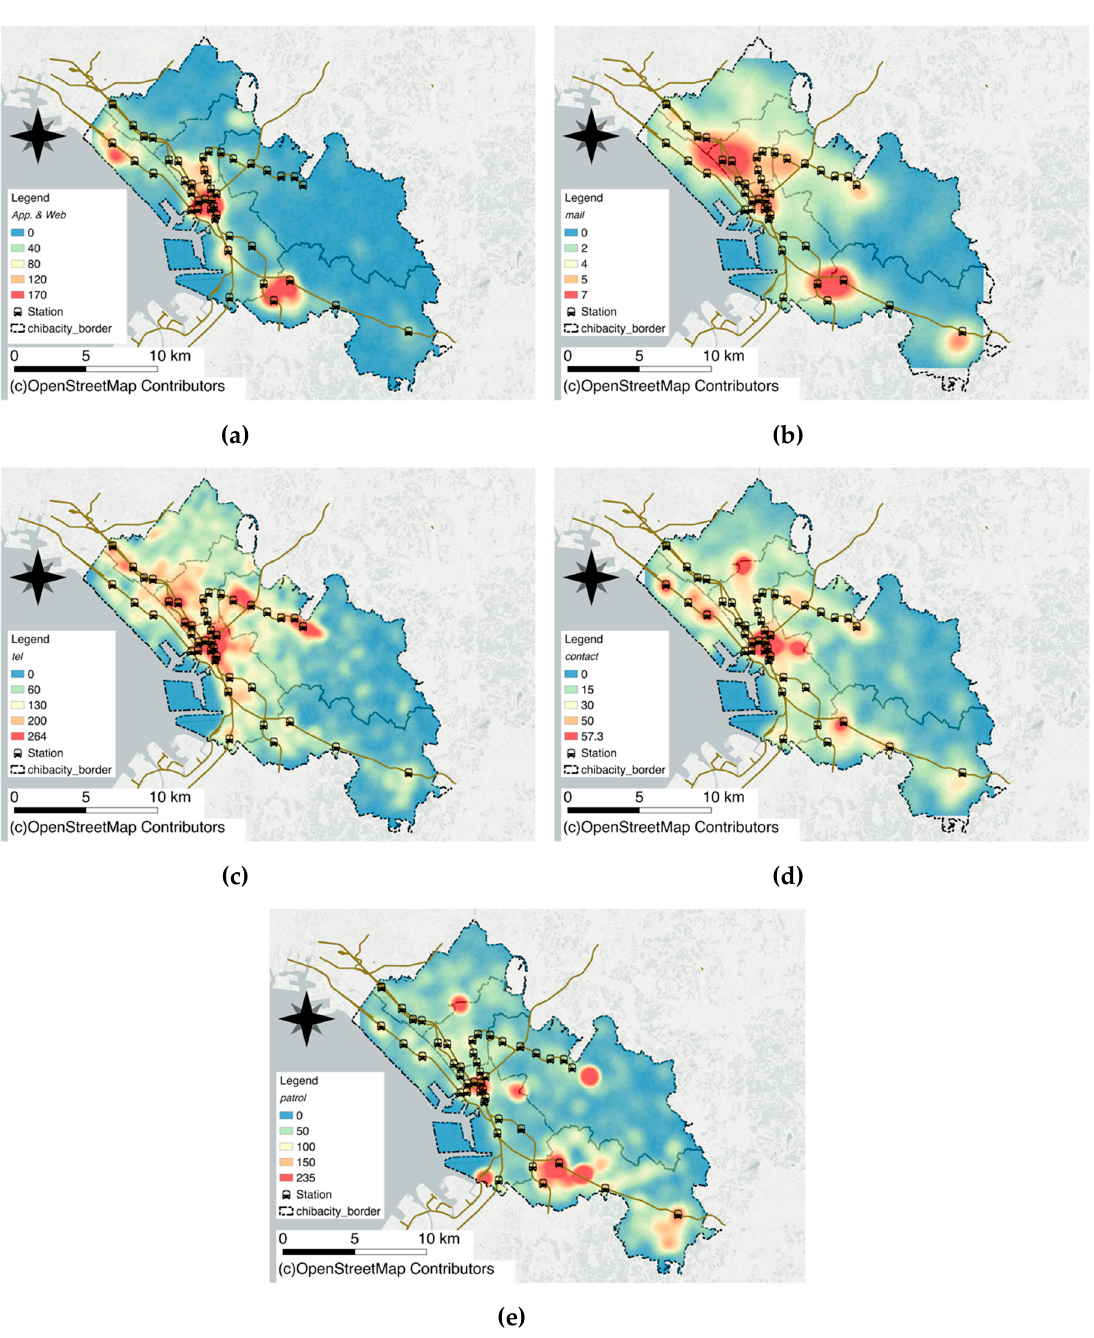
Figure 9. Spatial kernel density distribution of reports from ( a ) the app and web, ( b ) email, ( c ) telephone, ( d ) counter contact, and ( e ) patrols (kernel density radius = 250 m, cell size = 50 m). Table 1. Comparison of spatial correlation by report method.